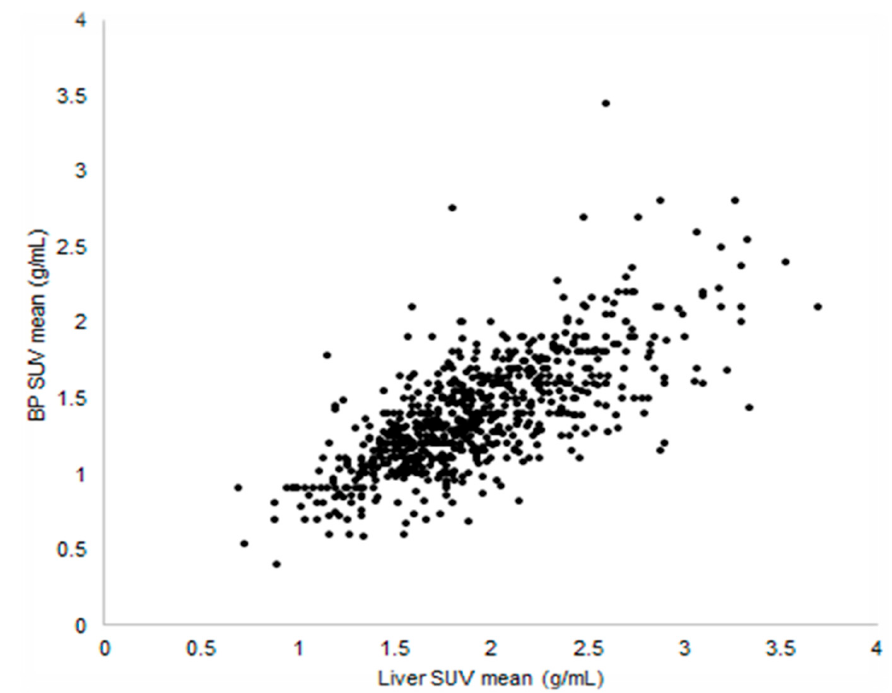
Figure 1. SUV (standardized uptake value) mean in the blood pool versus liver in a cohort of 1132 patients acquired on 56 different PET/CT scanners.